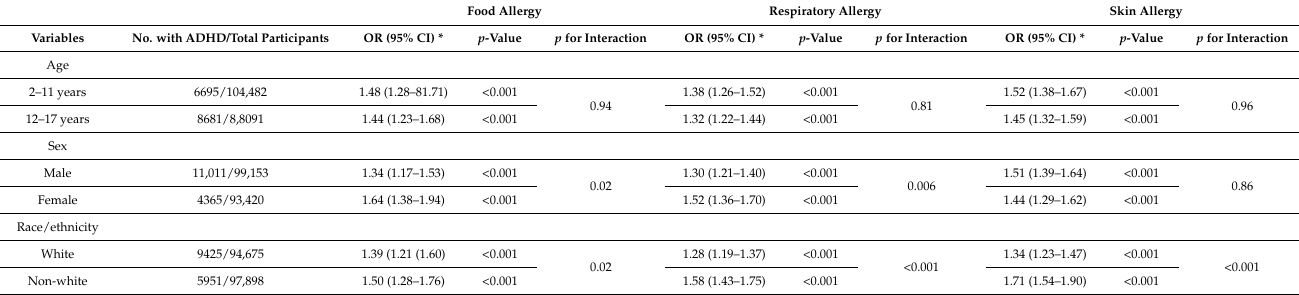
Table 5. Stratified analyses by age, sex, and race/ethnicity for the association of allergic conditions with